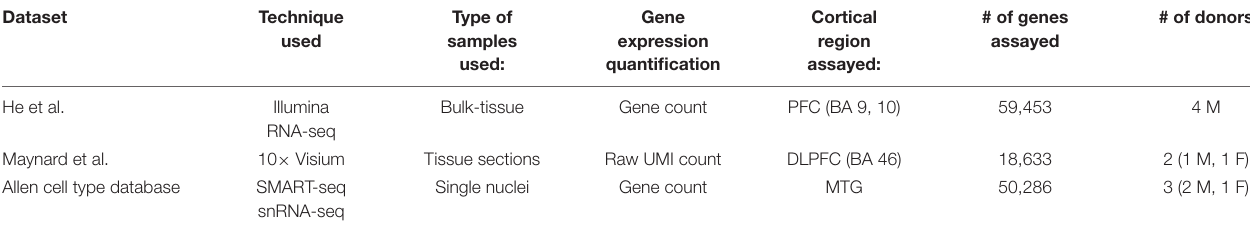
TABLE 1 | Characteristics of the datasets used in analysis.